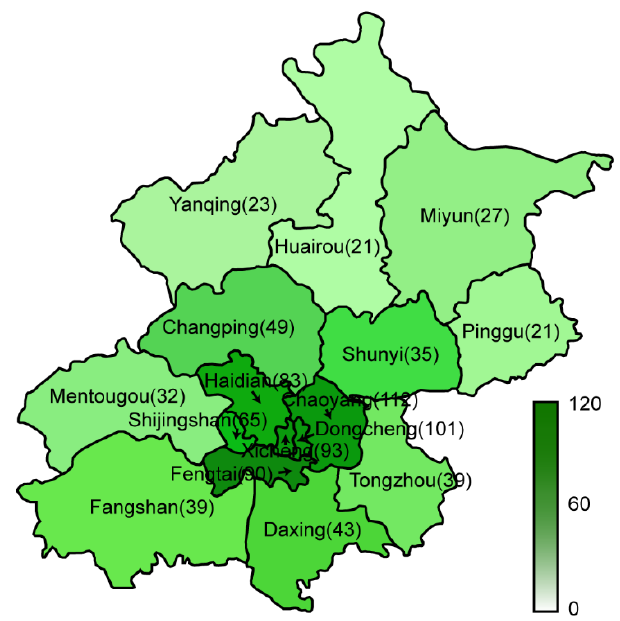
Figure 4. The distribution of respondents in